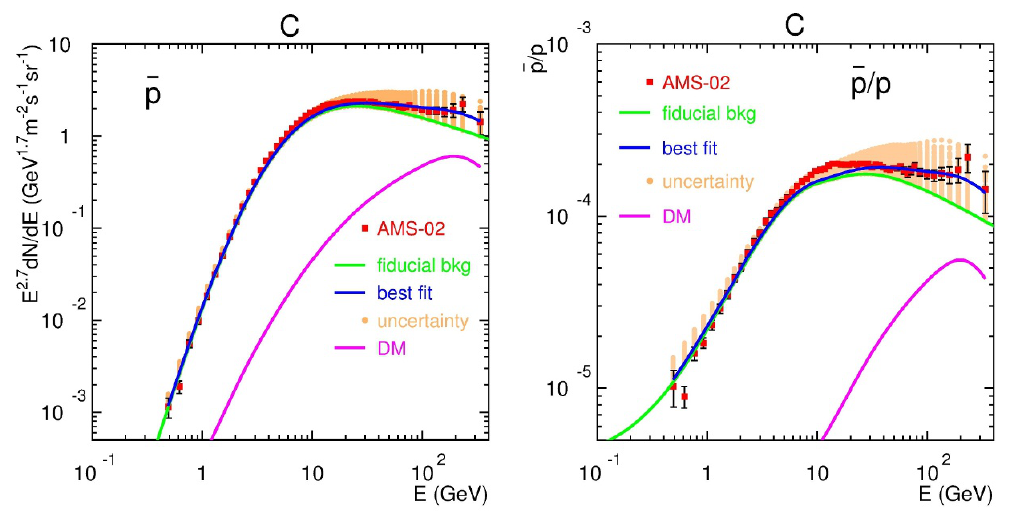
Figure 3 . Antiproton (cid:13)ux (left) and antiproton-to-proton ratio (right) observed by AMS-02 (red dots and dark error bars) in the simpli(cid:12)ed dark matter model C .